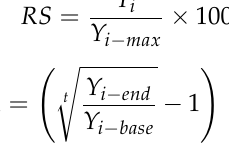
Figure 2. Boston Consulting Group matrix. With RS and GR representing the relative share and growth rate, respectively, to reflect the relative position and degree of change in urban industrial land in a city in the region; Y i representing the urban industrial land area of city i ; Y i − max representing the maximum urban industrial land area among the 41 cities; Y i − base and Y i − end representing the urban industrial land area of city i in the beginning and end periods, respectively; and t and n representing the time of the study and number of cities, RS and GR are calculated as